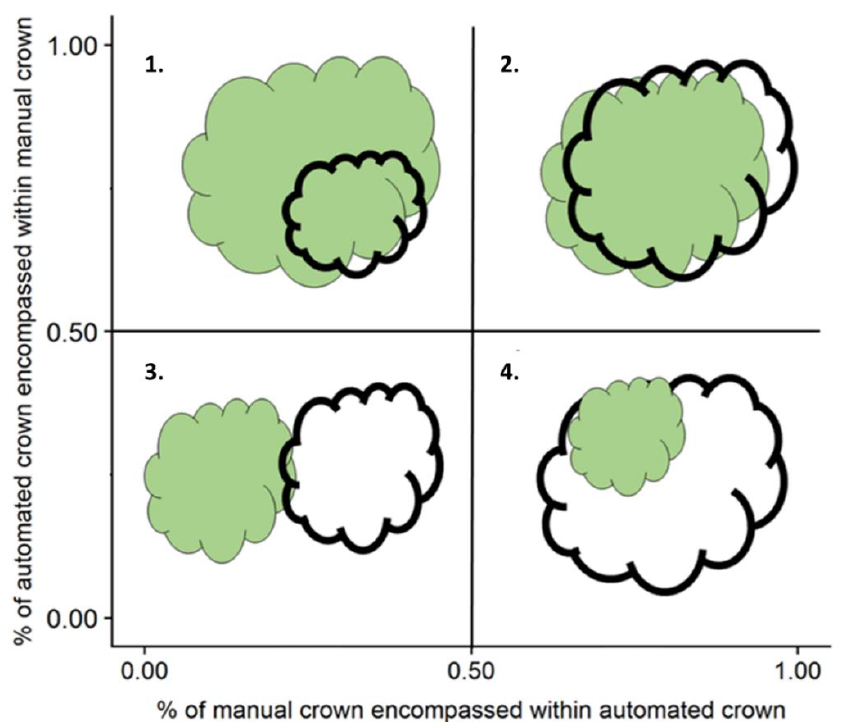
Figure 2. Automated crown delineations (A ITC ; shown with bold outline) were assessed against manual crown delineations (M ITC ; shown with green fill) and assigned into one of four categories based on overlapping area: (1) Over-segmentation: The intersecting area between A ITC and M ITC is greater than or equal to 50% of the area of only A ITC . (2) True Positive: The intersecting area between A ITC and M ITC is greater than or equal to 50% of the area of both A ITC and M ITC . (3) Under-segmentation: The intersecting area between A ITC and M ITC is greater than or equal to 50% of the area of only M ITC . (4) False Positive: The intersecting area between A ITC and M ITC is less than 50% of the area of both A ITC and M ITC .